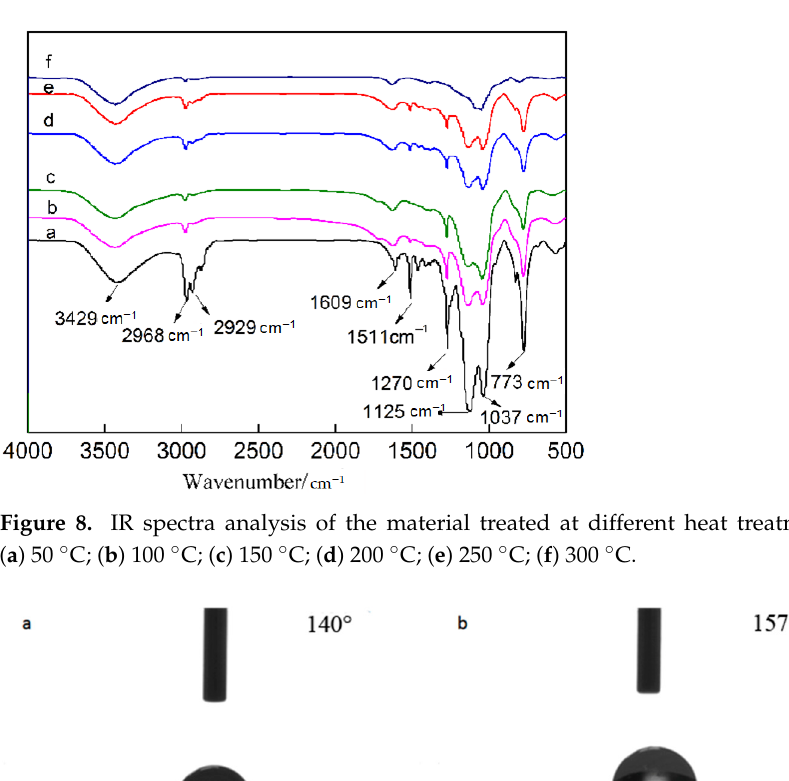
Figure 7. TG-DTG curve of the superhydrophobic bulk material.